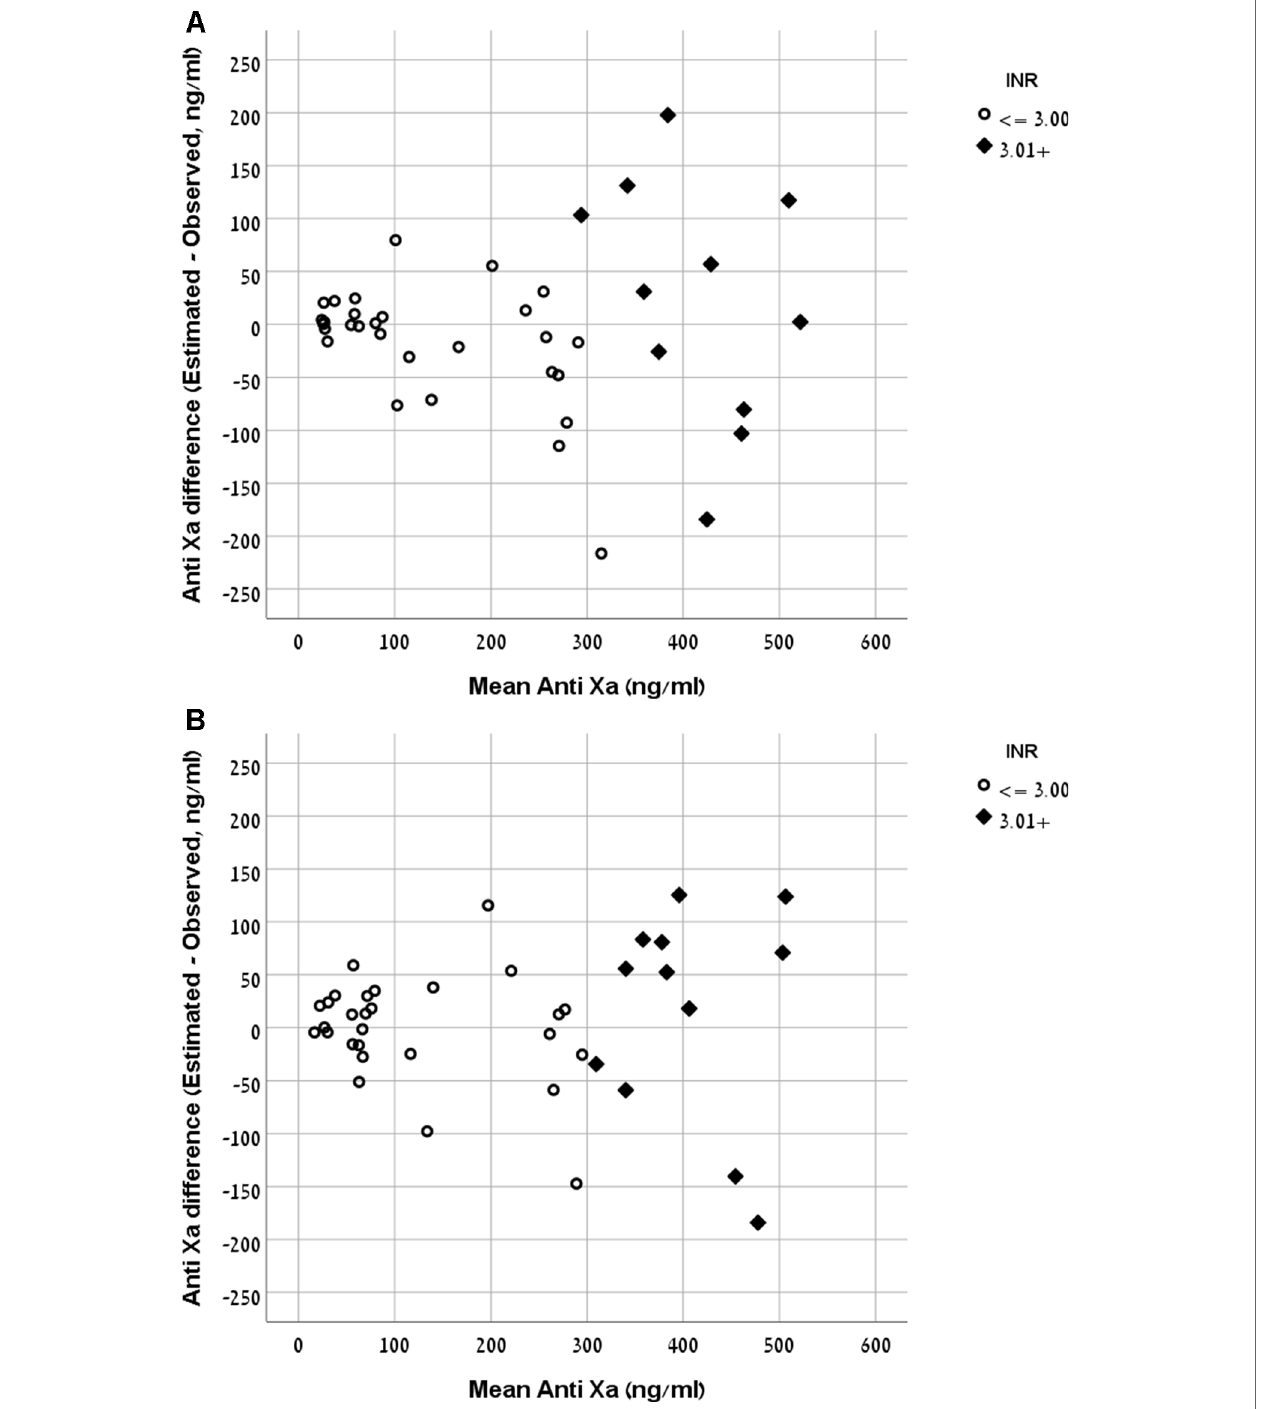
FIGURE 3 | (A) Bland and Altman plot demonstrating the mean value of observed and expected versus the difference between them in the rivaroxaban derivation cohort. (B) Bland and Altman plot demonstrating the mean value of observed and expected versus the difference between them in the rivaroxaban validation